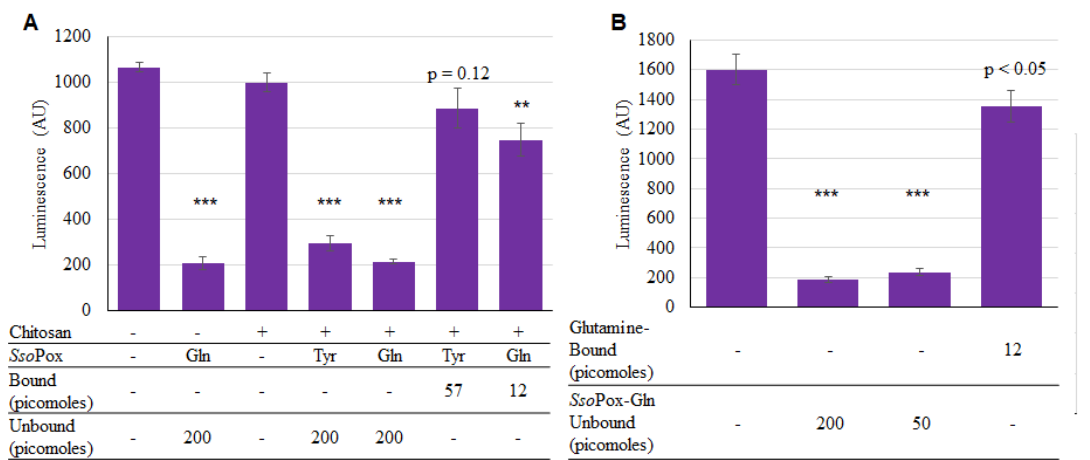
Figure 5: Activity of bound Sso Pox-Tyr/Gln. In ( A ), 200 pmol of unbound Sso Pox, and 57 and 12 pmol of Sso Pox-Tyr and Sso Pox-Gln, respectively were bound; samples were incubated for 2 h at 37 °C with 225 µM AI-1 solution. In ( B ), only Sso Pox-Gln was tested and samples were incubated 1 h, again at 37 °C with 20 µM AI-1 solution. In both charts the bars are the average of three samples with standard deviations provided. P-values are ca lculated by Student’s T -Test, two tails, type 2; ** < 0.008, *** < 0.0008.